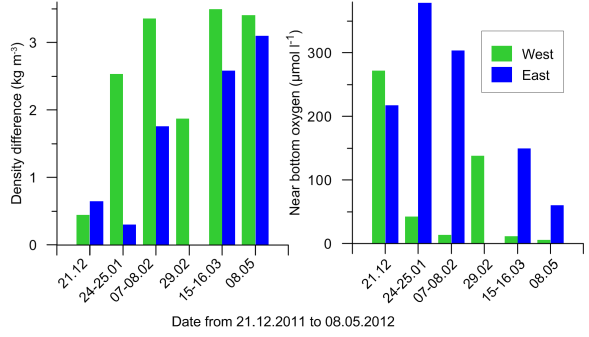
Figure 7. Average density difference between near-bottom and surface water (kg m -3 , left panel) 2 Fig. 7. Average density difference between near-bottom and sur- and oxygen concentration in the near-bottom layer (µmol l –1 , right panel) at westernmost stations 3 face water (kgm − 3 , left panel) and oxygen concentration in the A1 – A3 (green) and easternmost stations A8 – A10 (blue) from 21 December to 8 May. On 29 4 February, only the western part of the section was visited. 5 near-bottom layer (µmolL − 1 , right panel) at westernmost stations 6 A1–A3 (green) and easternmost stations A8–A10 (blue) from 21 December to 8 May. On 29 February, only the western part of the section was